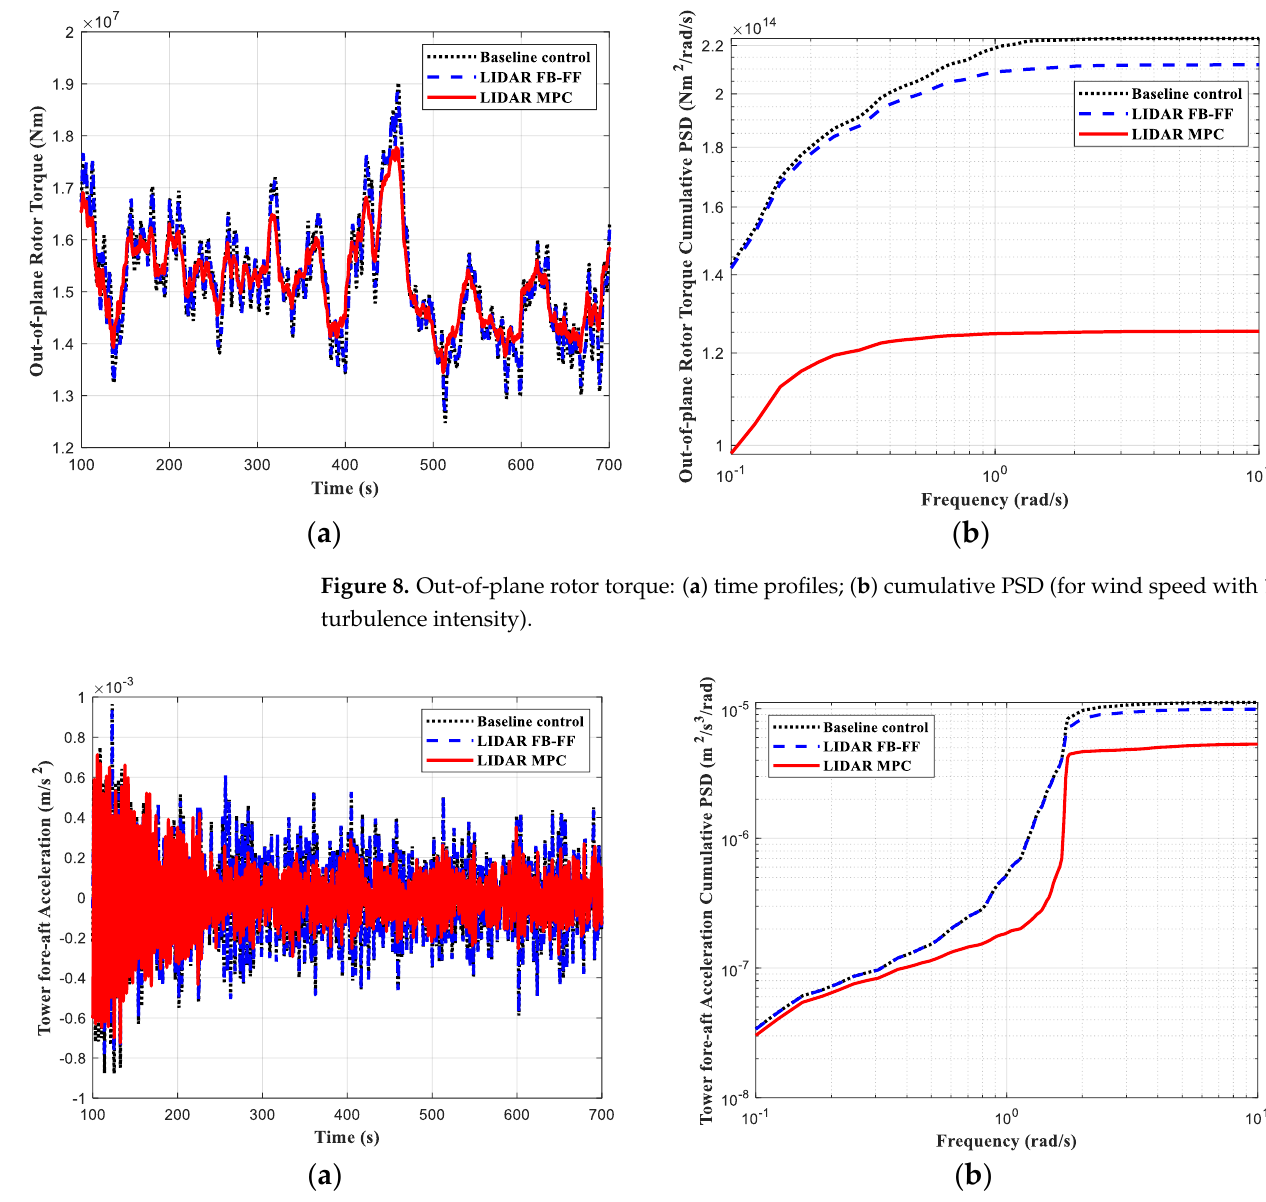
Figure 10. Comparison of the generator speed (wind speed with 10% turbulence intensity).